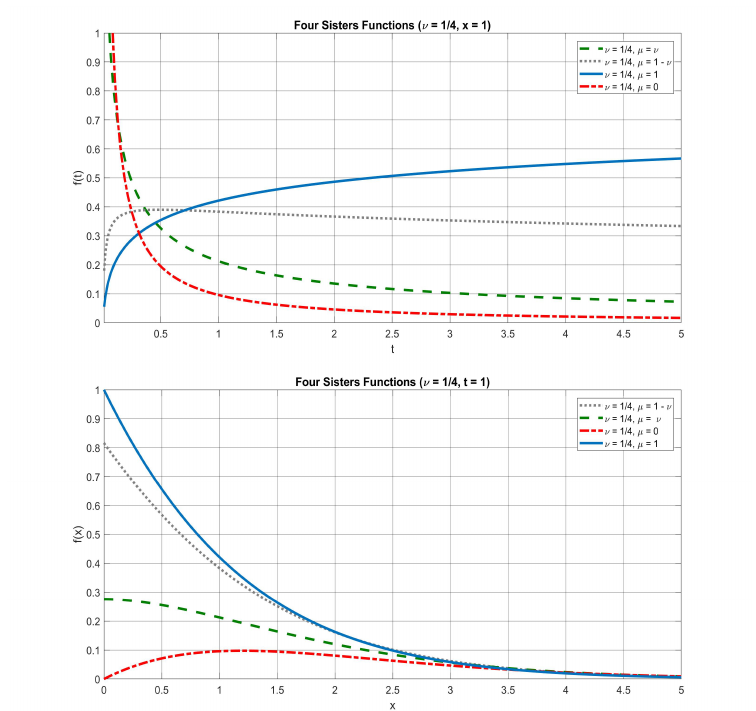
Figure 7. Plots of the four sisters functions in linear scale with ν = 1/4; top: versus t ( x = 1), bottom: versus x ( t = 1).